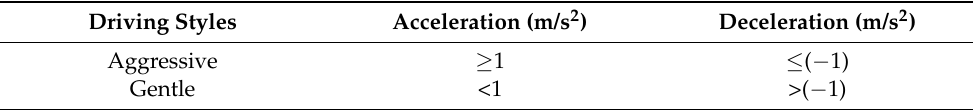
Table 3. Classification of driving styles.